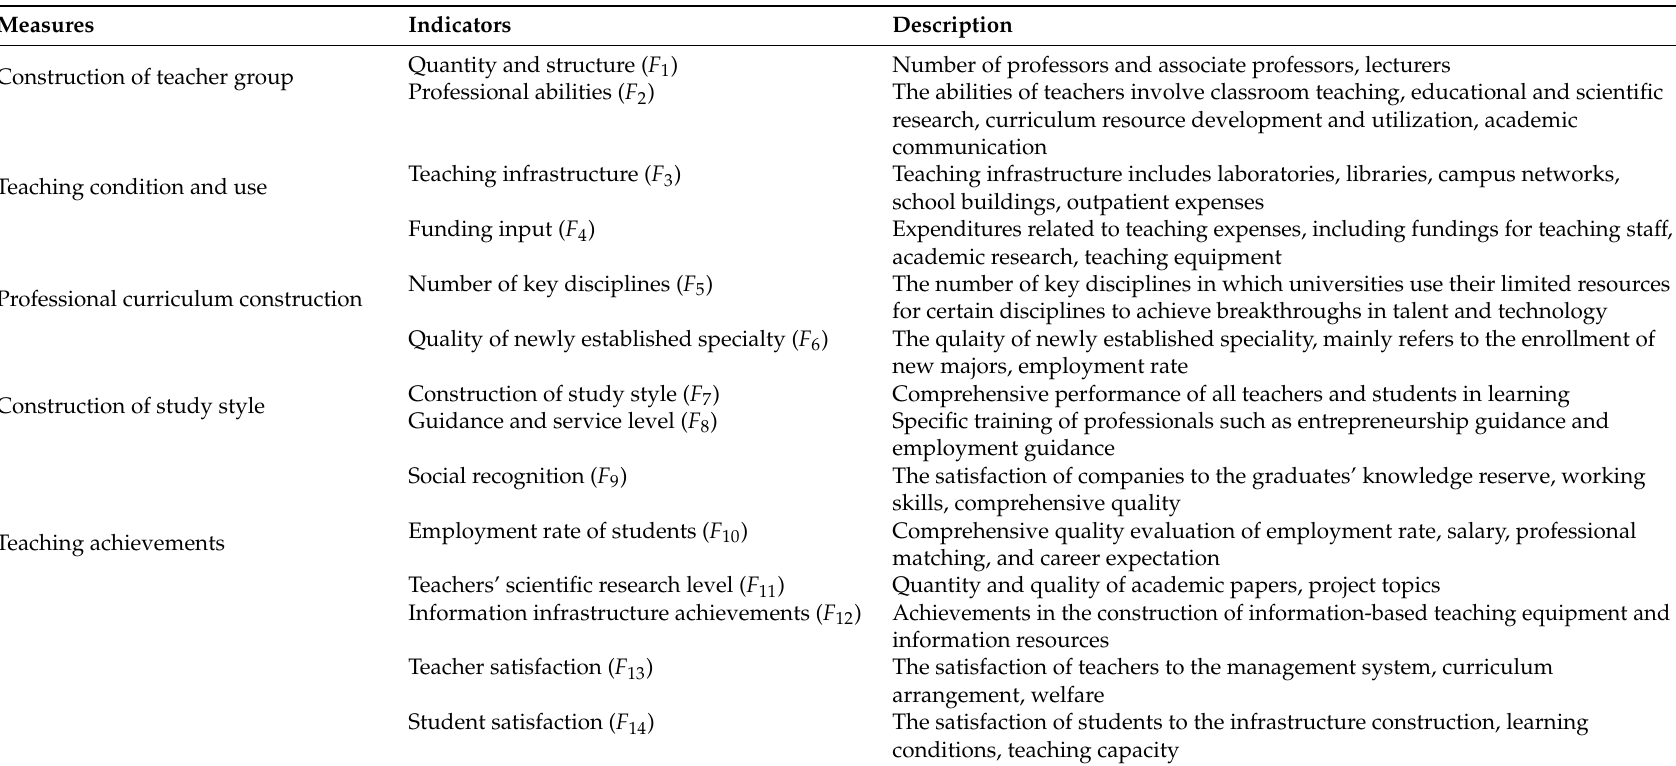
Table 1. Performance indicators considered in the case